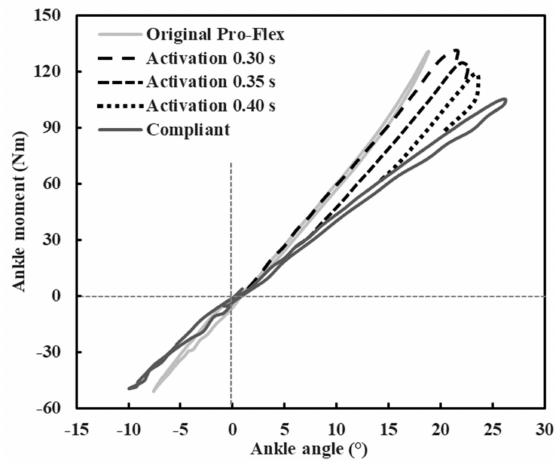
Figure 9. Ankle moment vs. ankle angle results from the FE model. Comparison between di ff erent activation times of the functional element. The actuation times correspond to 50%, 58%, and 67% of the stance phase. Damping coe ffi cient of the activated element is 300 Ns /